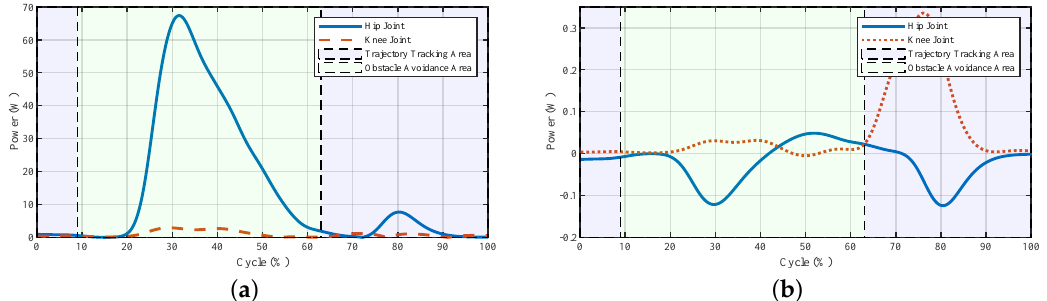
Figure 13. Joint powers of the system during stepping over a ball-like obstacle. ( a ) Powers of the exoskeleton and ( b ) powers of the interaction. The larger powers of the exoskeleton meant that the exoskeleton tried to change the current movement, and larger powers from the pilot indicated that the pilot tried to dominate the movements.